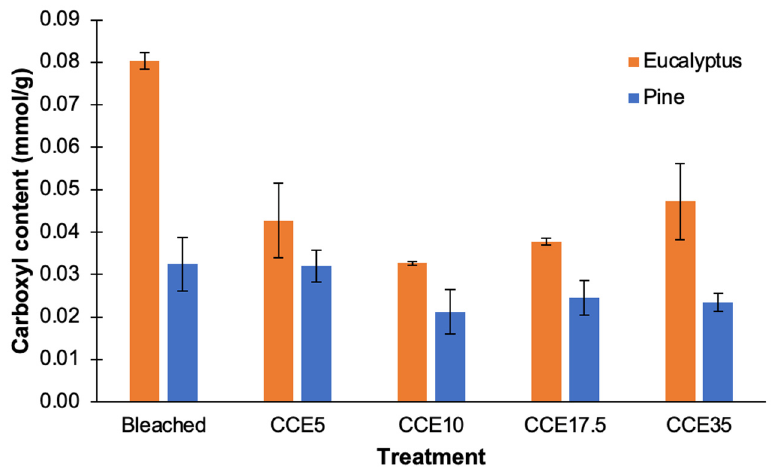
Figure 7. Carboxyl content of bleached and CCE-treated kraft pulps from eucalyptus and pine.